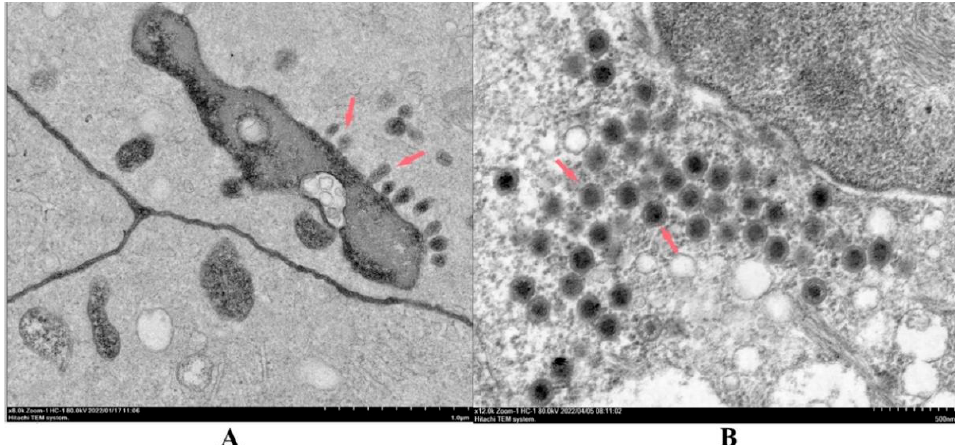
Figure 5. TEM analysis of infected MSH cells. All samples were prepared from the same batch and were observed using TEM, 80.0 kV. ( A ) Rhabdovirus-like viral particles (red arrows), and ( B ) iridovirus-like viral particles (red arrows).